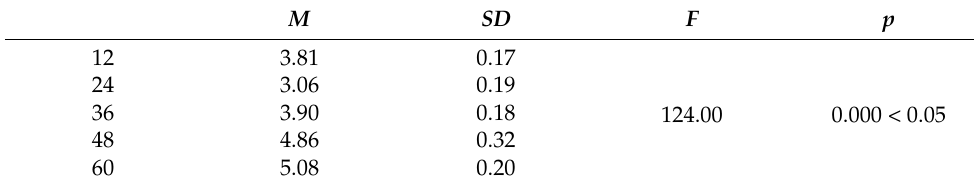
Figure 11. Response time of each speed target under intensity 87 stimulation. Table 5. Time statistic value under intensity 87.